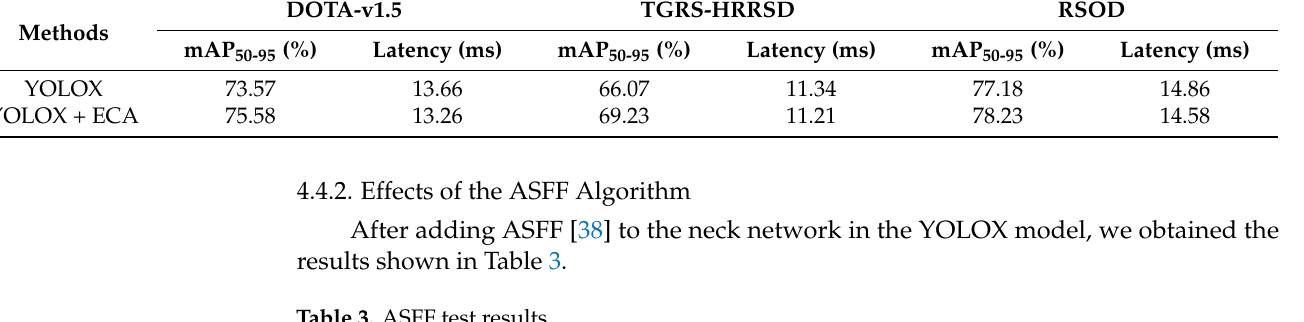
Table 3. ASFF test